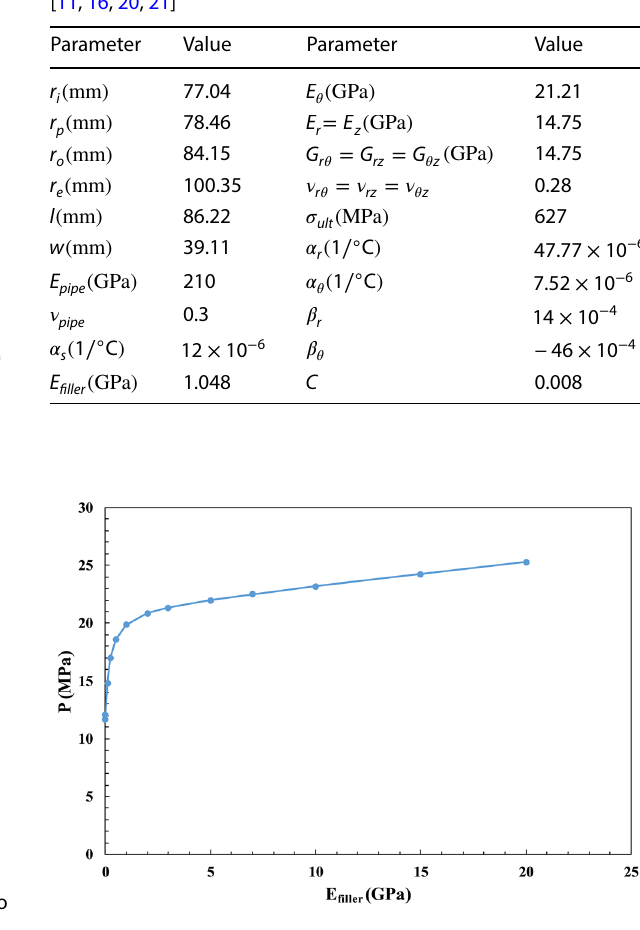
Fig. 19 Burst pressure versus elasticity modulus of